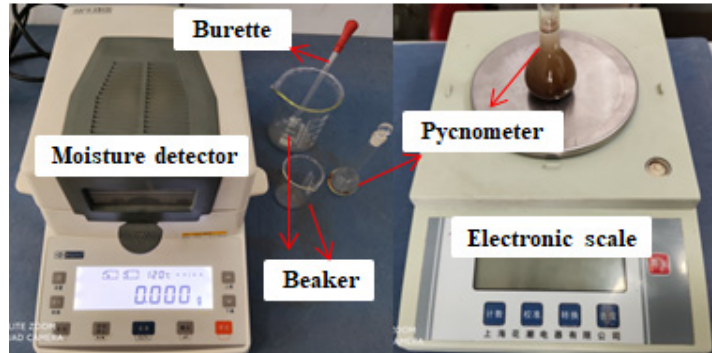
Figure 6. Soil moisture content and particle density test device.